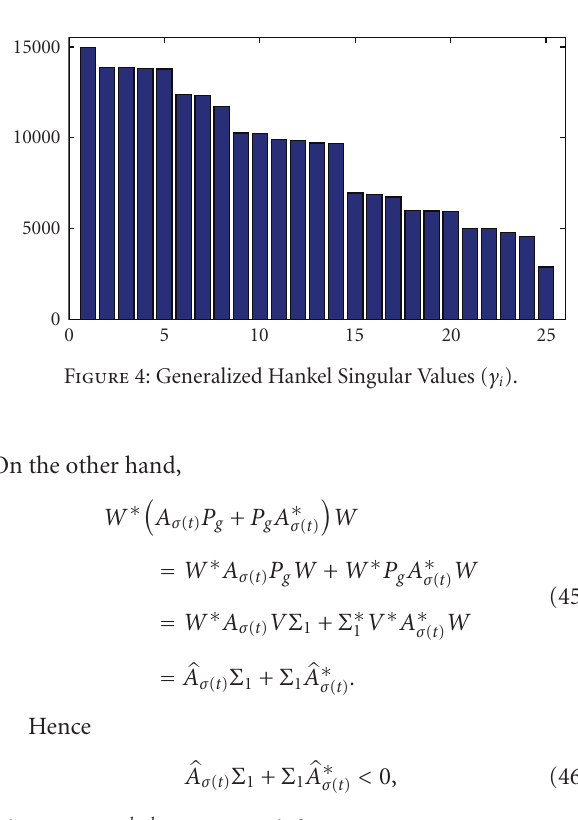
Figure 3: Step response of original switched linear system (solid line) and the reduced-order model (dotted).